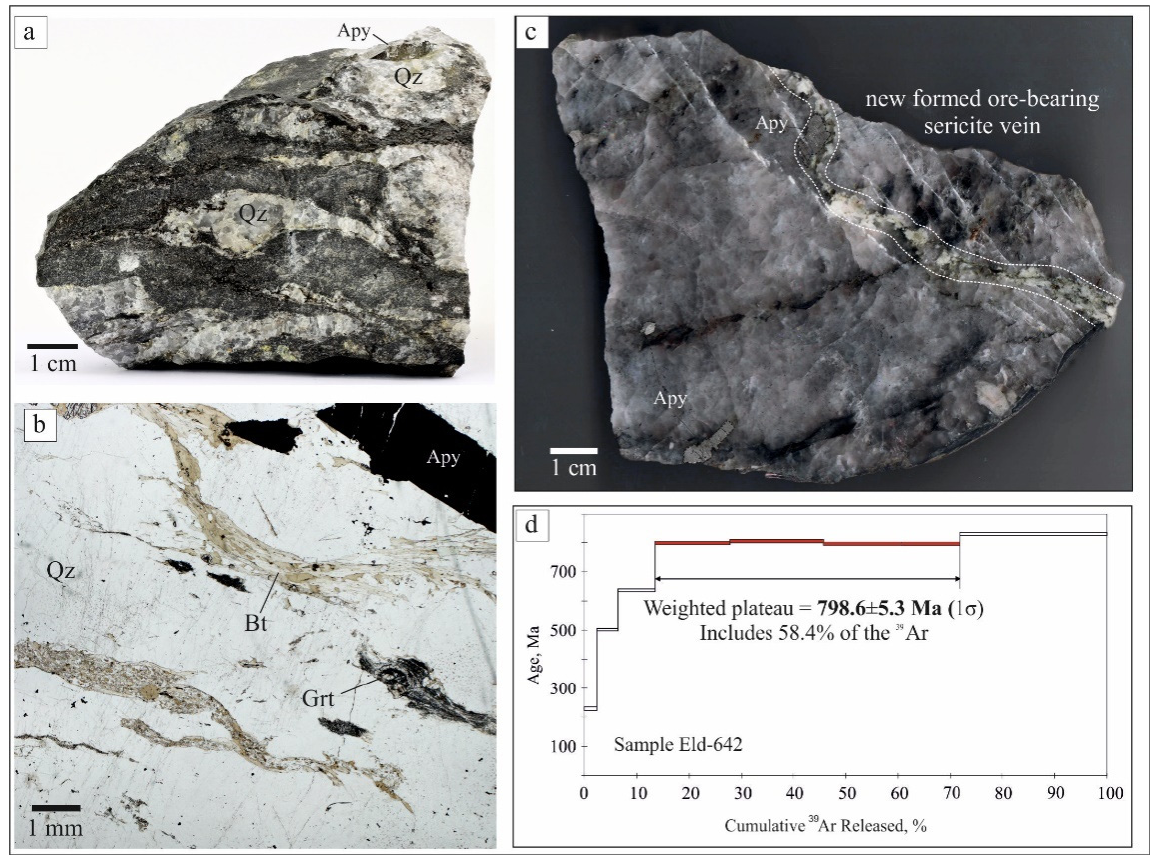
Figure 9. Photograph of the sample of quartz vein in garnet-biotite schist from the Eldorado deposit ( a ), photomicrograph of thin section of quartz vein with relicts of host schists and inclusions of arsenopyrite ( b ), quartz vein cut by sericite vein used for Ar-Ar dating ( c ), weighted plateau of Ar-Ar age of sericite ( d ). Table 6. Ar-Ar sericite data.